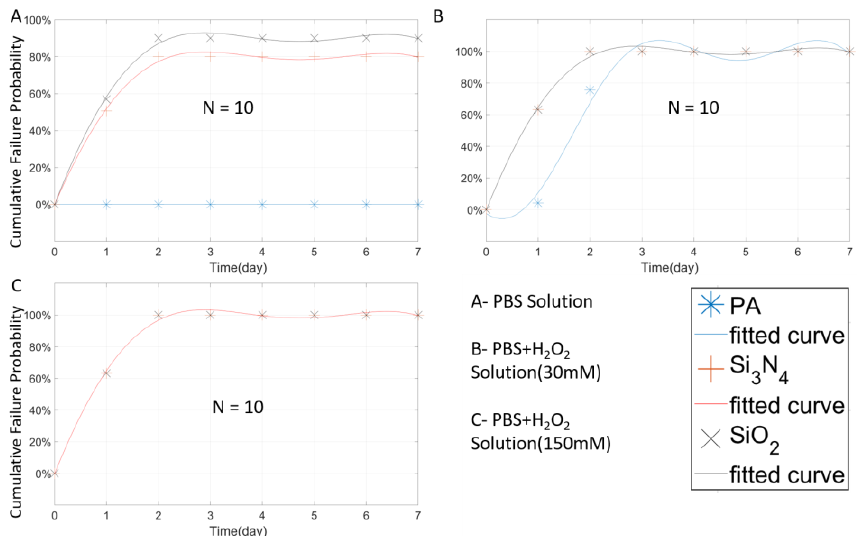
Figure 5. The Weibull cumulative distribution data and corresponding curve fitting of open-tip tungsten wires with a single layer coating (1 µm) of PA, Si 3 N 4, and SiO 2 , tested at 67 °C in different solutions (the curves in B and C may overlap).